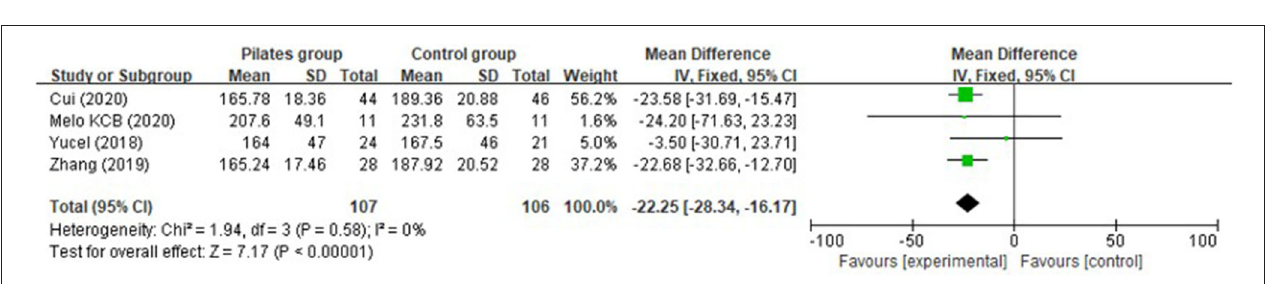
2019) (MD = − 76.20 mg/dL, 95% CI: [ − 98.68, − 53.72] mg/dL, P < 0.0001, I 2 was not applicable) and three studies (Tunar et al., 2012; Abd EL-Monim et al., 2019; Batar et al., 2020) (MD